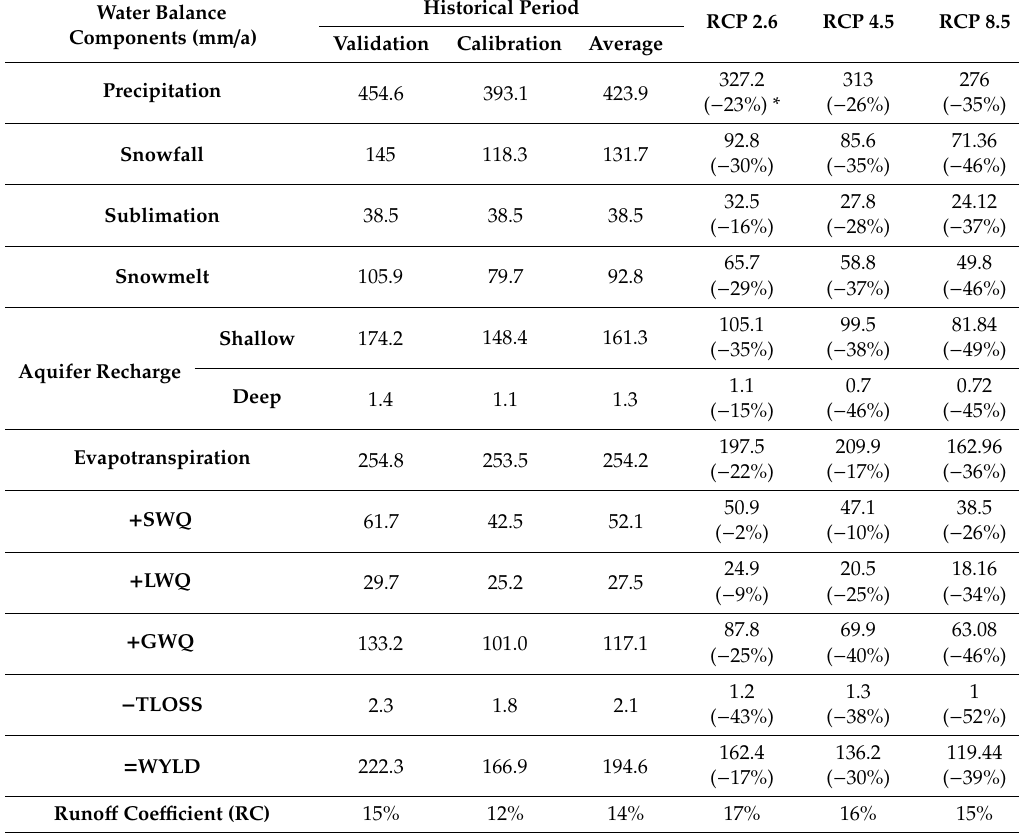
Table 6. Annual SWAT-modeled water balance components for the ZRB for the historical reference of the six variants for each of the two climatic scenarios, RCP 2.6 and RCP 4.5 for the future period (2012–2029). Red line bordered cells mark the flow contributions to the total water yield